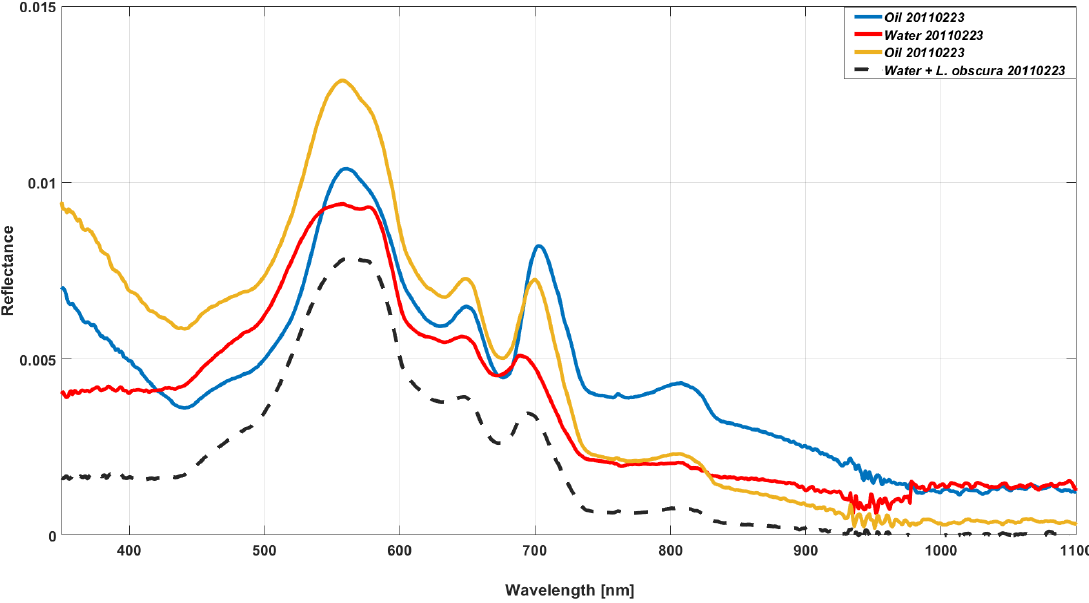
Figure 2. Examples of oil spectra compared with water spectra. Note the characteristic peak of reflectance at 0.705 micron, due to Lemna obscura , a floating vegetation typical of Lake Maracaibo.